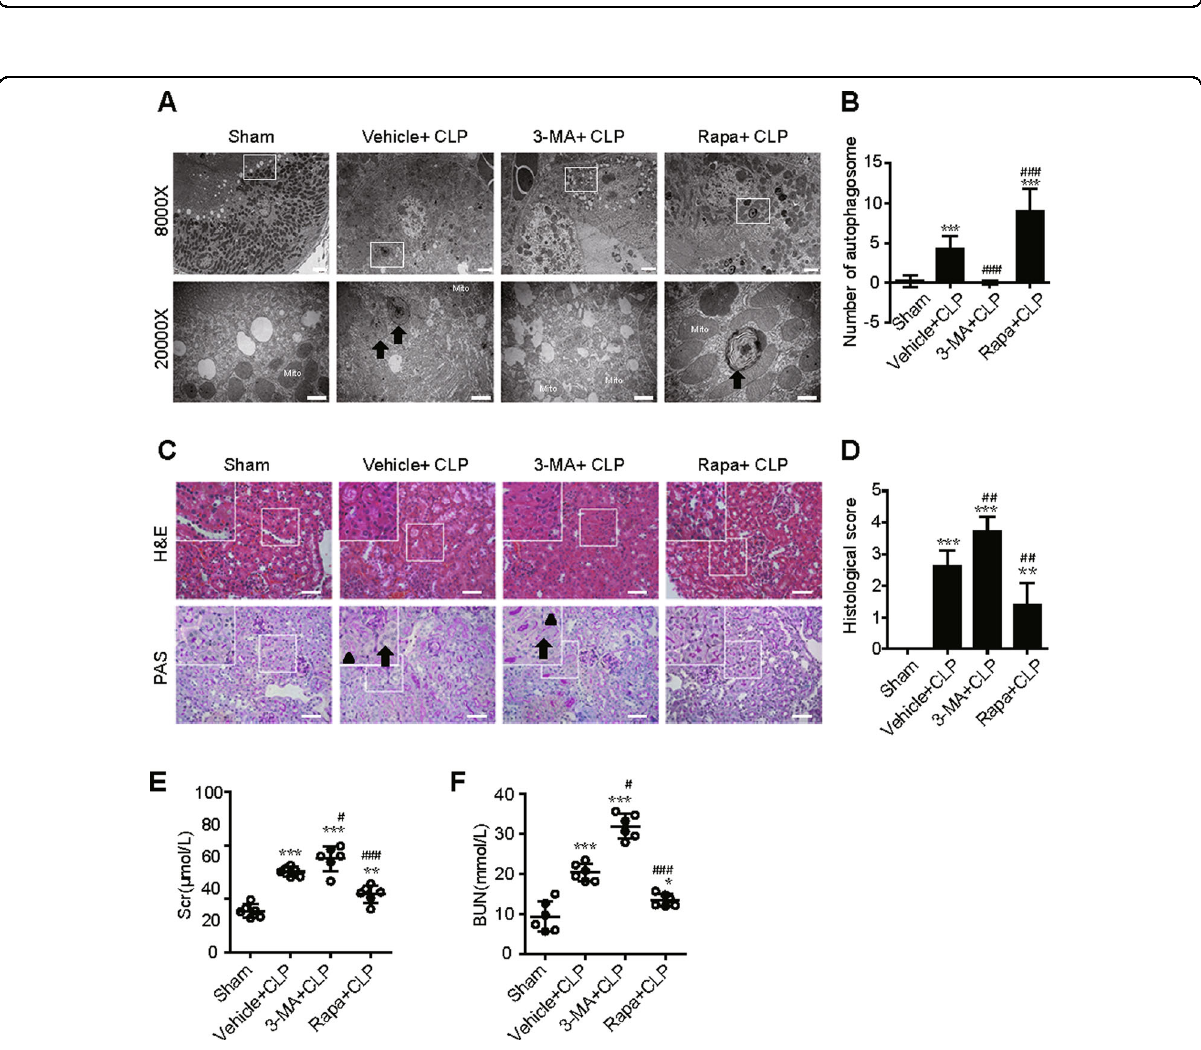
Fig. 2 Activation of autophagy protects against SAKI in RTECs. Autophagy activation or inhibition by pretreatment with Rapa or 3-MA, respectively. The samples were collected 12 h after CLP-induced SAKI. A , B The number of autophagosomes in renal epithelial cells was calculated in 20 randomly selected fi elds using a transmission electron microscope (black arrow: autophagosomes; Mito: mitochondrion; upper panel: magni fi ed ×8000 and scale bar = 2 μ m; lower panel: magni fi ed ×20000 and scale bar = 1 μ m, n = 20). C The irregular brush border (arrow) and ectasia of affected tubules (arrowheads) were observed by H&E staining (upper panel, 200×; inset: 400×; scale bar = 10 μ m) and PAS staining (lower panel, 200×; inset: 400×; scale bar = 10 μ m) of the kidney cortex. D The tubular damage score was evaluated based on H&E and PAS staining ( n = 10). E Scr levels ( n = 6). F Serum BUN levels ( n = 6). The data are presented as the mean ± SD. * p < 0.05, ** p < 0.01 and *** p < 0.001 vs the sham group; # p < 0.05, ## p < 0.01 and ### p < 0.001 vs the vehicle + CLP group. RTECs renal tubular epithelial cells, SAKI sepsis-induced acute kidney injury, CLP caecal ligation and puncture, PAS periodic acid-Schiff staining, H&E haematoxylin – eosin staining, Rapa rapamycin, Scr serum creatinine, BUN urea nitrogen.